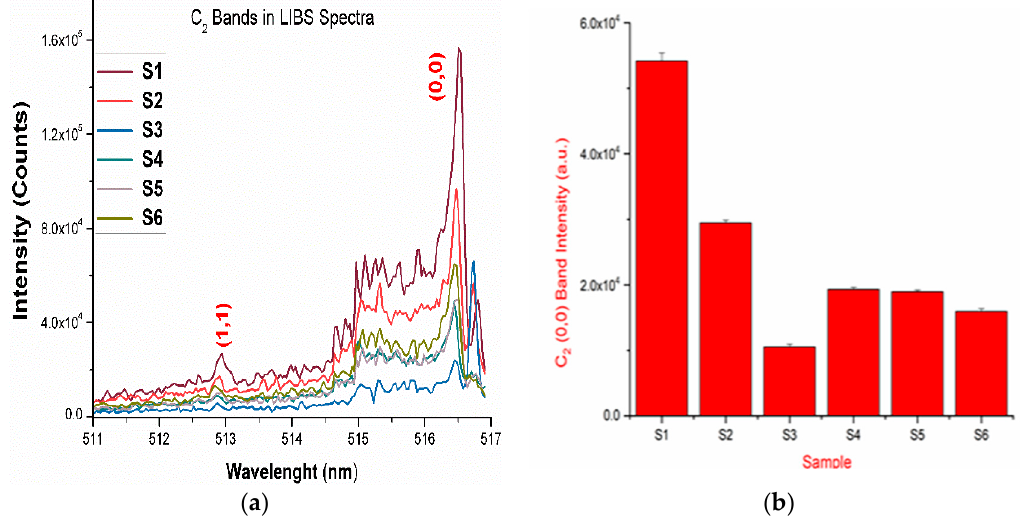
Figure 3. ( a ) The LIBS spectra of the drugs showing the presence of the vibrational band of a C 2 molecule; ( b ) intensities of the (0,0) band of the C2 band present in the LIBS spectra of the drugs.